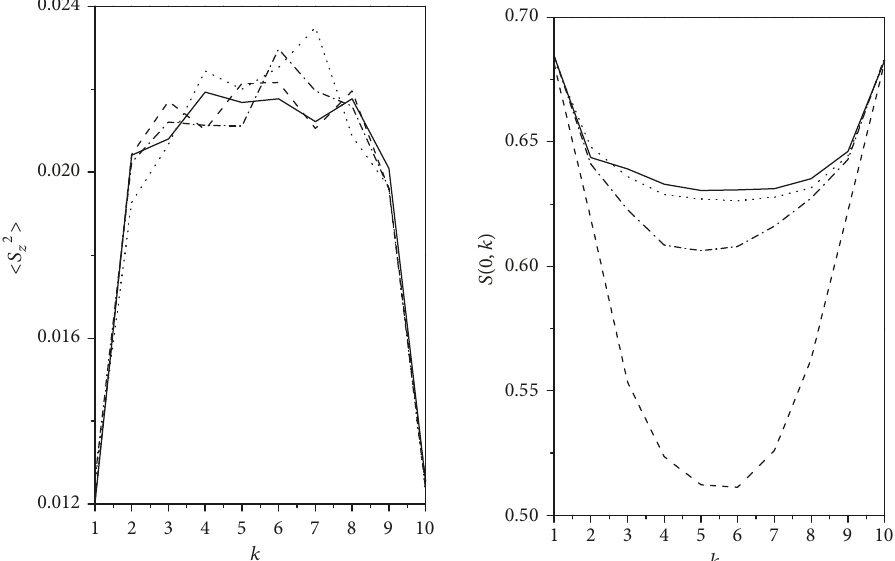
Figure 4: Dependence of the plane parameters ⟨𝑆 𝑧2 ⟩ (left) and S (0, k ) (right) on k in the case L = 10 (equilibrium spin configuration) for initial configurations “D” (solid line), “XH” (dashed line), “ZH” (dash-dotted line), and “R” (dotted